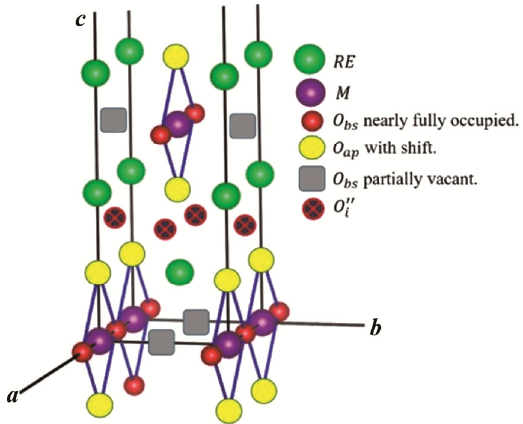
Fig. 4 Schematic representation of location of oxygen vacancies and interstitial oxide ions in A (cid:2870) BO (cid:2872) layered perovskite. Reproduced with permission from Ref. [66], © Royal Society of Chemistry